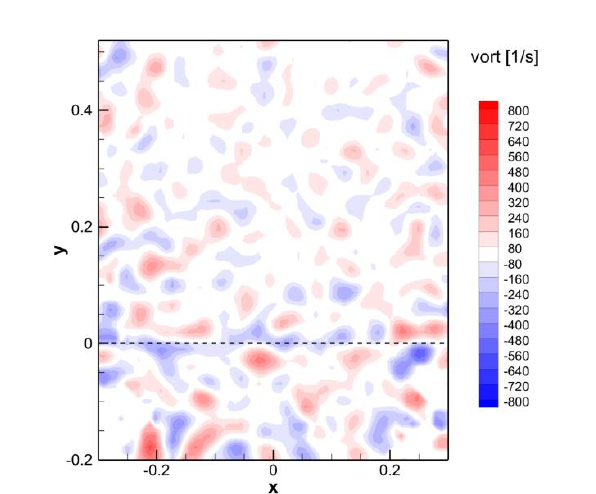
Fig. 13. Example of the instantaneous vorticity field. Re = 1M.